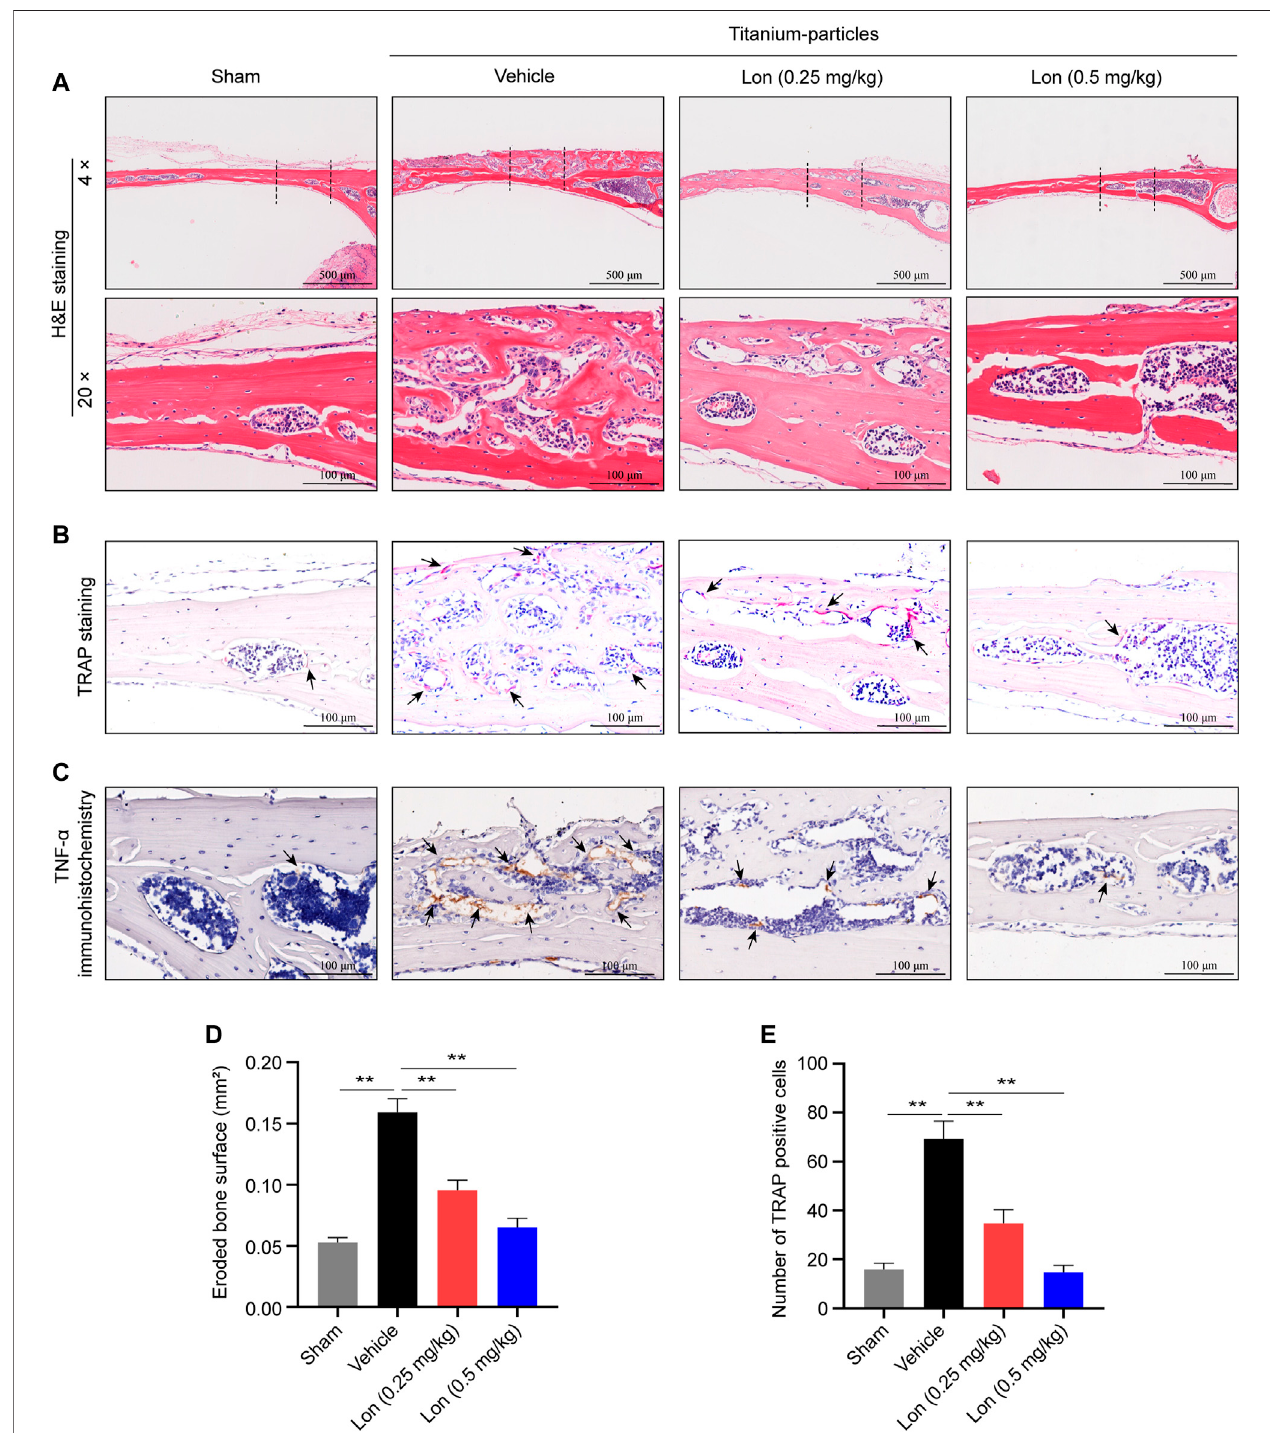
FIGURE4| Londecreasesosteoclastformationandproductionofpro-in fl ammatorycytokine invivo. (A – C) Representativeimagesofhistomorphometryofmouse calvaria staining with H&E, TRAP and TNF- α immunohistochemistry. (D) Quantitative analyses of eroded bone surface of ROI. (E) Quantitative analyses of numbers of TRAP-positive cells ofROI. All of theabove data areexpressed as the mean ± SD, n = 5per group. * p < 0.05, ** p < 0.01 relative to Vehicle group. H&E, hematoxylin and eosin; Lon, Lonafarnib; ROI, region of interest; TNF- α , tumor necrosis factor-alpha; TRAP, tartrate-resistant acid phosphatase.